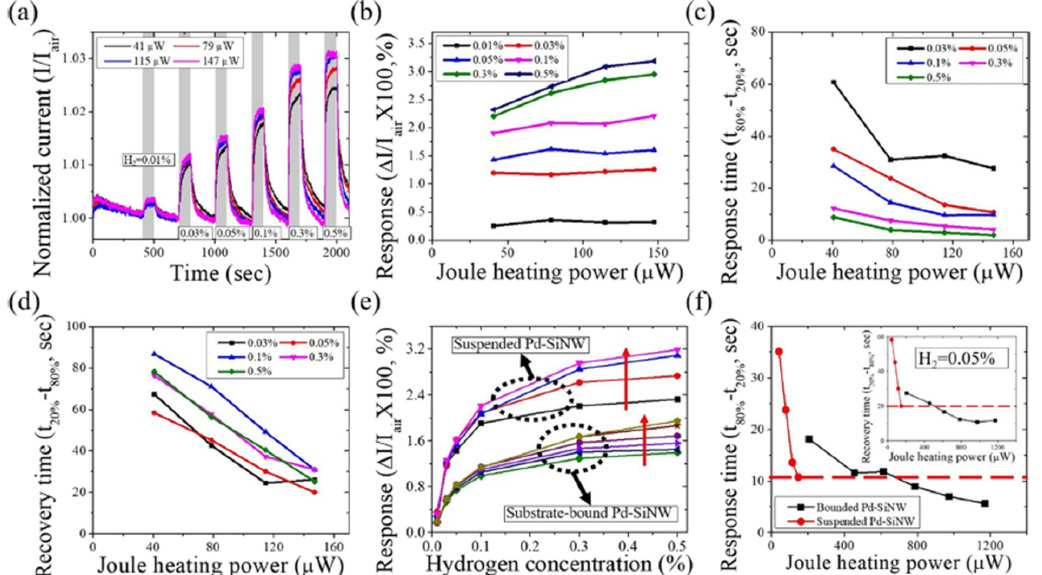
Figure 13. H 2 gas sensing of the suspended Pd-SiNW sensor: ( a ) normalized current with Joule heating powers of 41, 79, 115, and 147 μ W. The ( b ) response, ( c ) response time and ( d ) recovery time for variant H 2 concentrations at four Joule heating powers. Comparison between the substrate-bound and suspended Pd-SiNW sensors: ( e ) responses at various Joule heating powers (red arrows: direction of Joule heating power increment (from 41 to 147 μ W for the suspended Pd-SiNW and from 205 to 1172 μ W for the substrate-bound Pd-SiNW)) and ( f ) response time and recovery time (inset in ( f )) for 0.05% H 2 (red dotted line indicates the similarity of transient behaviour between the suspended Pd-SiNW at a Joule heating power of 147 and the substrate-bound Pd-SiNW at a Joule heating power of 613 μ W) [69]. Copyright (2019), with permission from American Chemical Society.